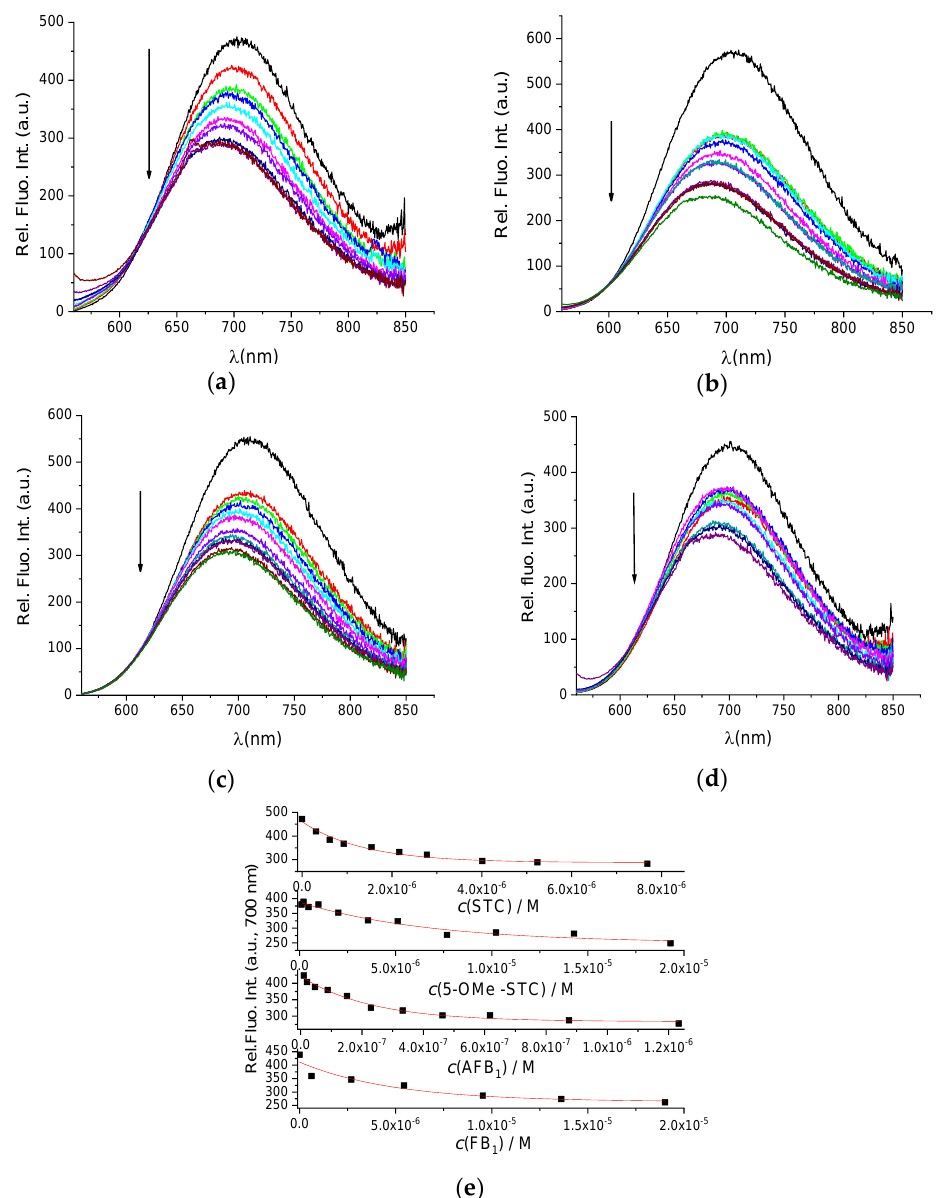
Figure 4. Change in fluorescent spectrum of AuNC@BSA (λ exc = 540 nm, c (BSA, AuNC@BSA) = 0.715 μ M or c (Au 25 , AuNC@BSA) = 0.379 µM in a cuvette) in water at 298 K upon titration with: ( a ) STC; ( b ) 5-OMe-STC; ( c ) AFB 1 ; ( d ) FB 1 ; and ( e ) emission dependence at λ max = 700 nm of AuNC@BSA on c (mycotoxin), red line-fit to the 1:1 stoichiometry complex formation. R 2 > 0.99 in all cases. Analysis of titration data (Figure 4a – d) by multivariate analysis using the SPECFIT